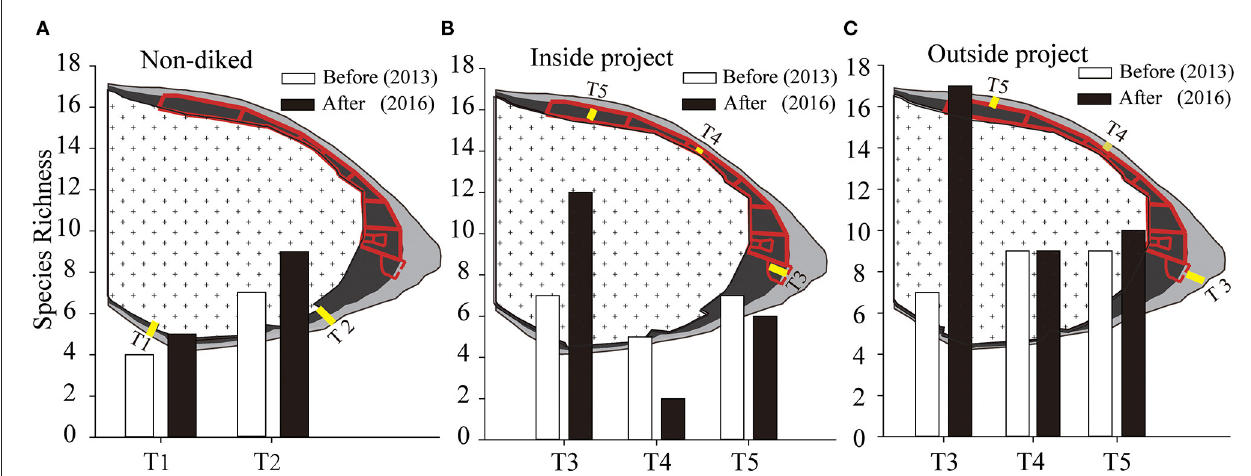
FIGURE 3 | Benthic macroinvertebrate richness in different sample transects before and after diking in the Chongming Dongtan salt marsh, Yangtze Estuary, China. (A) Non-diked area, (B) inside the dike project, and (C) outside the dike project